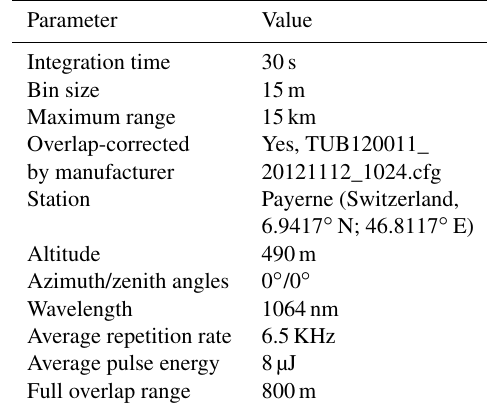
Table 1. Instrument